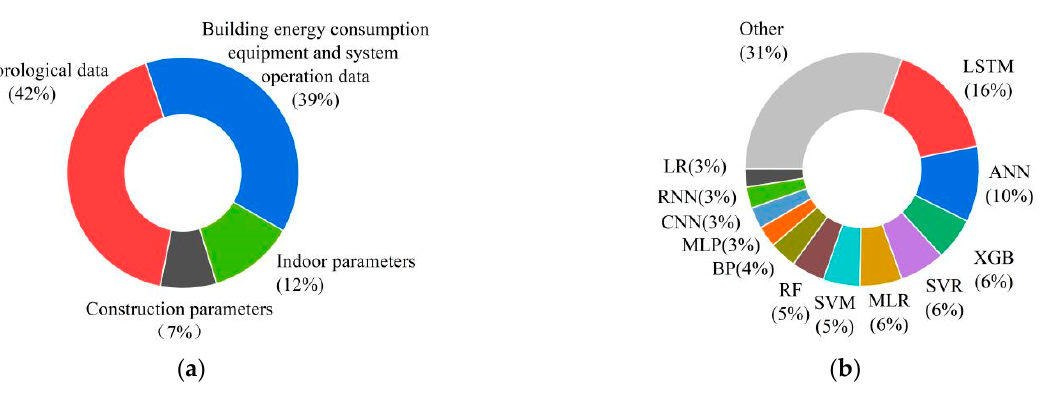
Figure 3. Distribution of the reviewed papers according to ( a ) type of the energy consumption feature data; and ( b ) type of ML algorithm used for BECP.